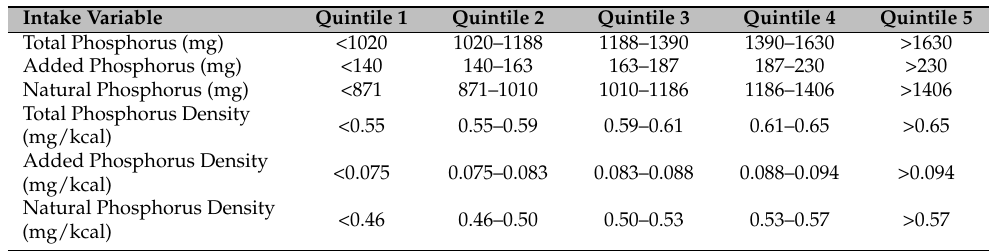
Table 3. Phosphorus intake quintile for mortality analyses, in adults 19+ years of age and older, NHANES